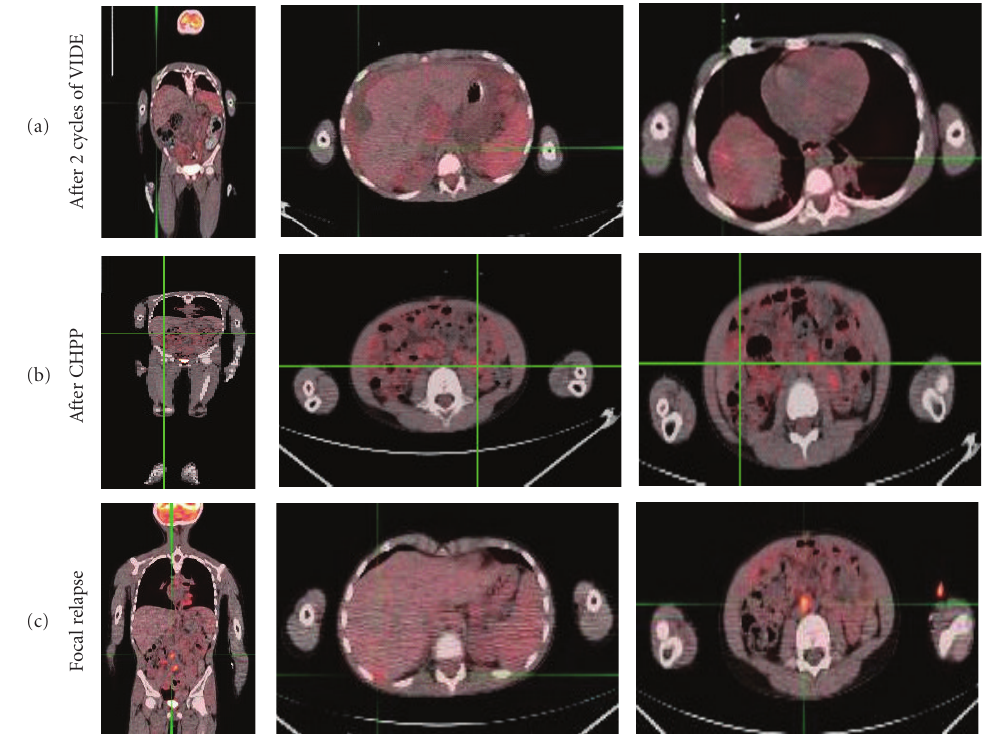
Figure 4: PET-CT fusion imaging . (a) Residual uptake in the peritoneal implants after 2 cycles of therapy, SUV 3. (b) No evidence of FDG avid disease after cytoreductive therapy. (c) Relapse in the perihepatic space including dome of the liver (SUV 2.8) and retroperitoneal nodes (SUV